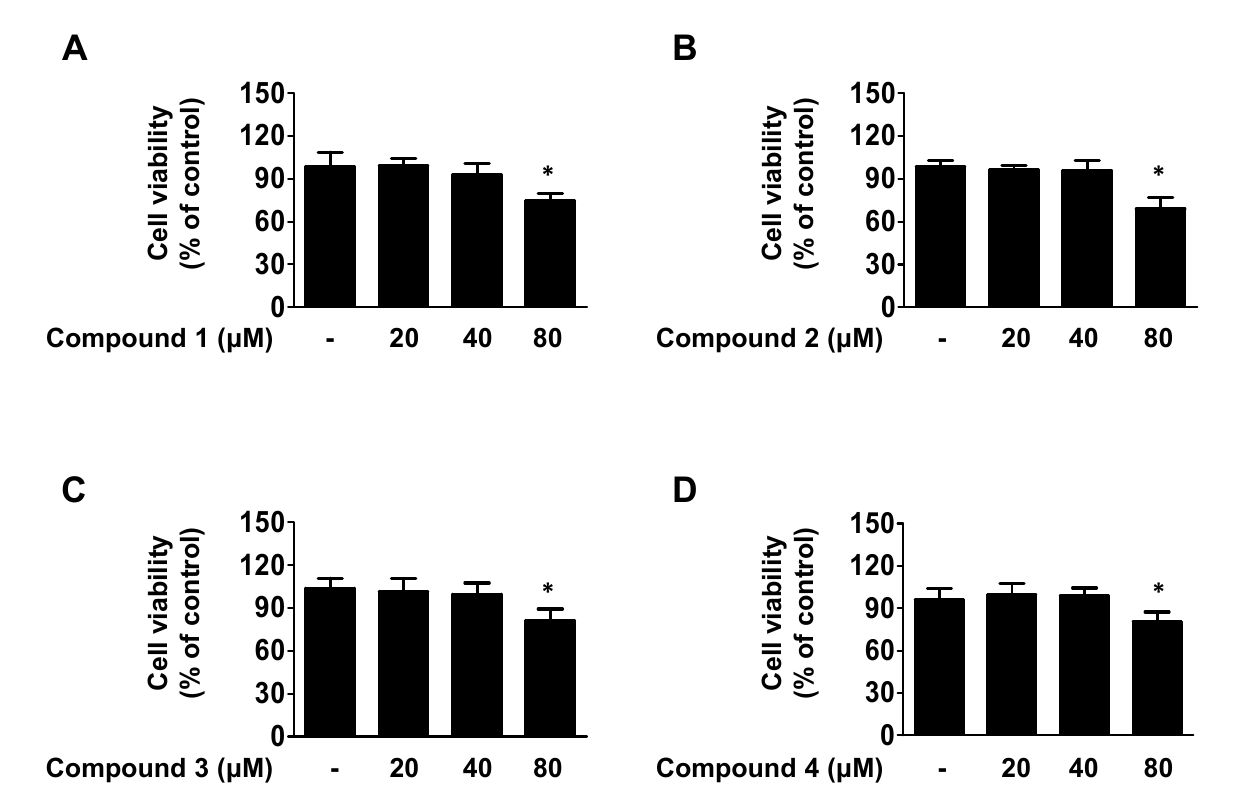
Figure 2. Cytotoxicities of the compounds 1 , 2 , 3 , and 4 used in this study( A – D ). Cells were treated for 24 h with the indicated concentration of each of the four compounds and the cytotoxicity was evaluated. Data are presented as the mean ± SD (n = 3). * p < 0.05 vs. control. Table 1. Inhibitory effects of the four isolated compounds on IL-8 and IL-6 production in TNF- α /IFN- γ -treated HaCaT cells. Results are represented as the mean ± SD (n = 3). Compounds concentration: a —40 µ